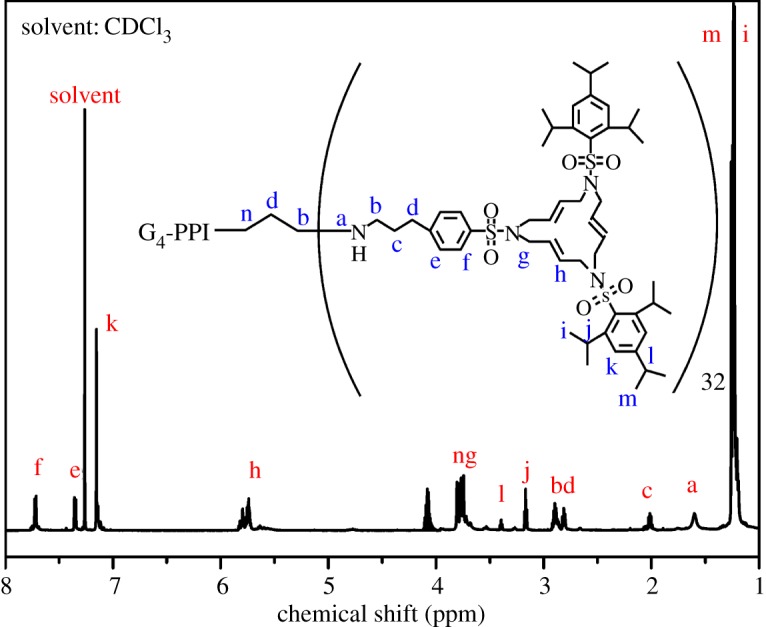
1H NMR spectrum of GnM (n = 4) (solvent: CDCl3).